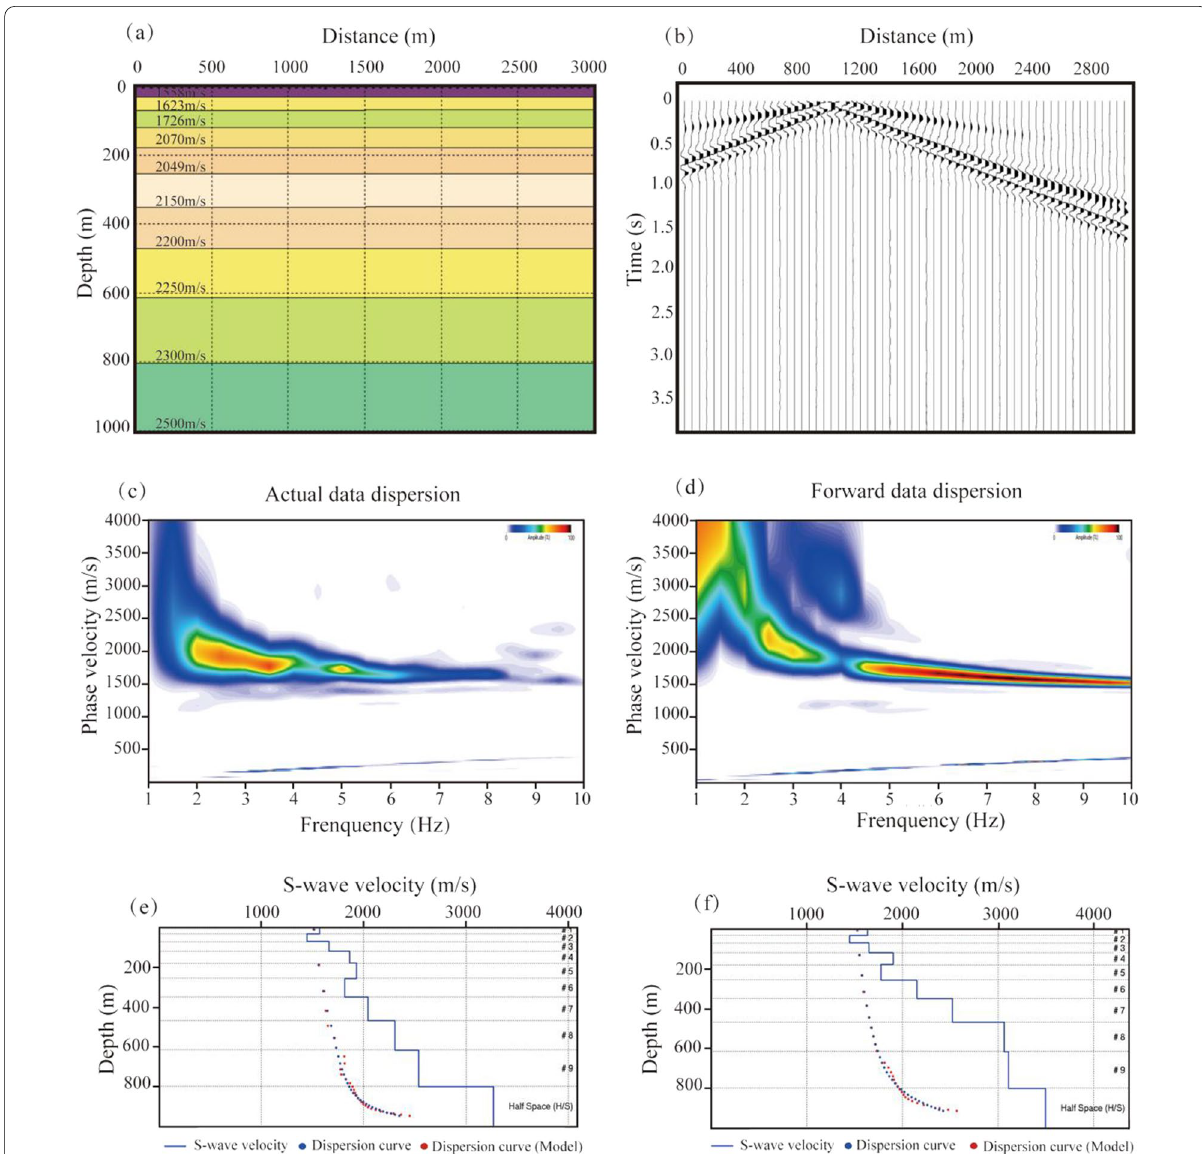
Fig. 6 Comparison between the forward simulation and actual data. a Forward model. b Forward single-shot record. c , d Actual data dispersion curve and simulated data dispersion curve. e , f Inversion results of dispersion curves of real and simulated